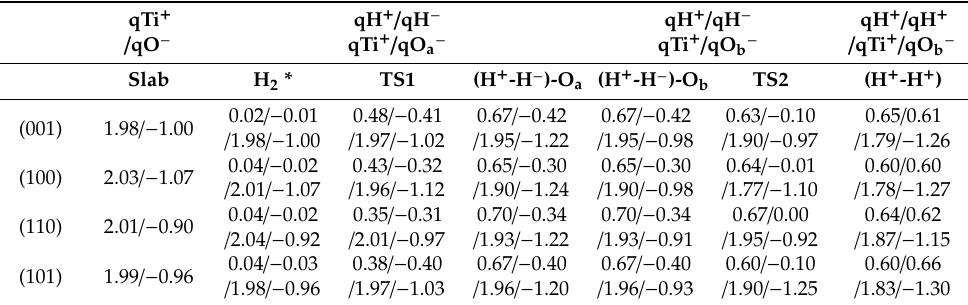
Figure 6. Spin density of TS2 ( a ) and (H + -H + ) species ( b ) indicating the distribution of unpaired electrons on the (001) facet. The spin densities for TS2 and (H + -H + ) species on the other three facets are shown in Supplementary Figure S5. Table 3. Bader charges ( | e | ) of H and involved Ti and O a in the H 2 dissociation process, and involved H, Ti, and O b in subsequent H transfer from Ti to O process for H 2 *, TS and (H + -H − ), and (H + -H + ). For step 1, the O involved was labeled O a , and O b in step 2.